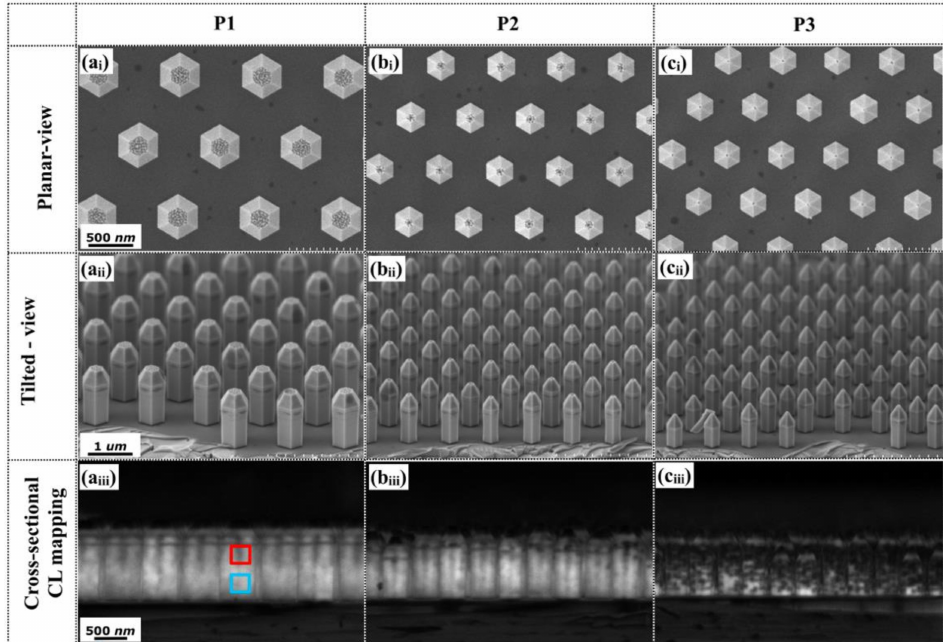
Figure 5. ( a i – c i ) Planar and ( a ii – c ii ) tilted-view SEM images of patterns p 1 , p 2 , and p 3 of NW sample e, grown at a well temperature of 730 °C; Panels ( a iii – c iii ) are the corresponding panchromatic CL